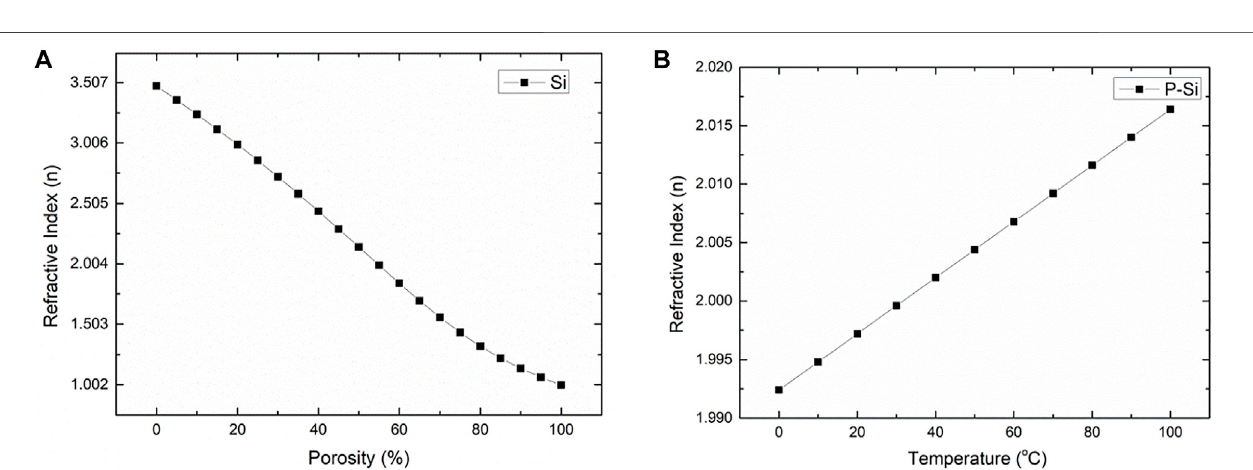
FIGURE 2 | (A) Variations in the refractive index with porosity for silicon material and (B) variations in the refractive index with temperature for the porous silicon material.